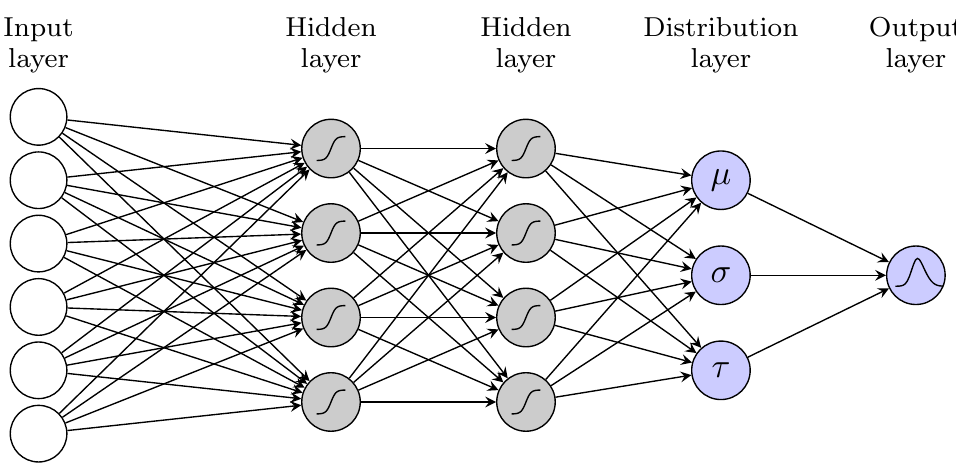
Figure 6. Exemplary network structure of the probabilistic